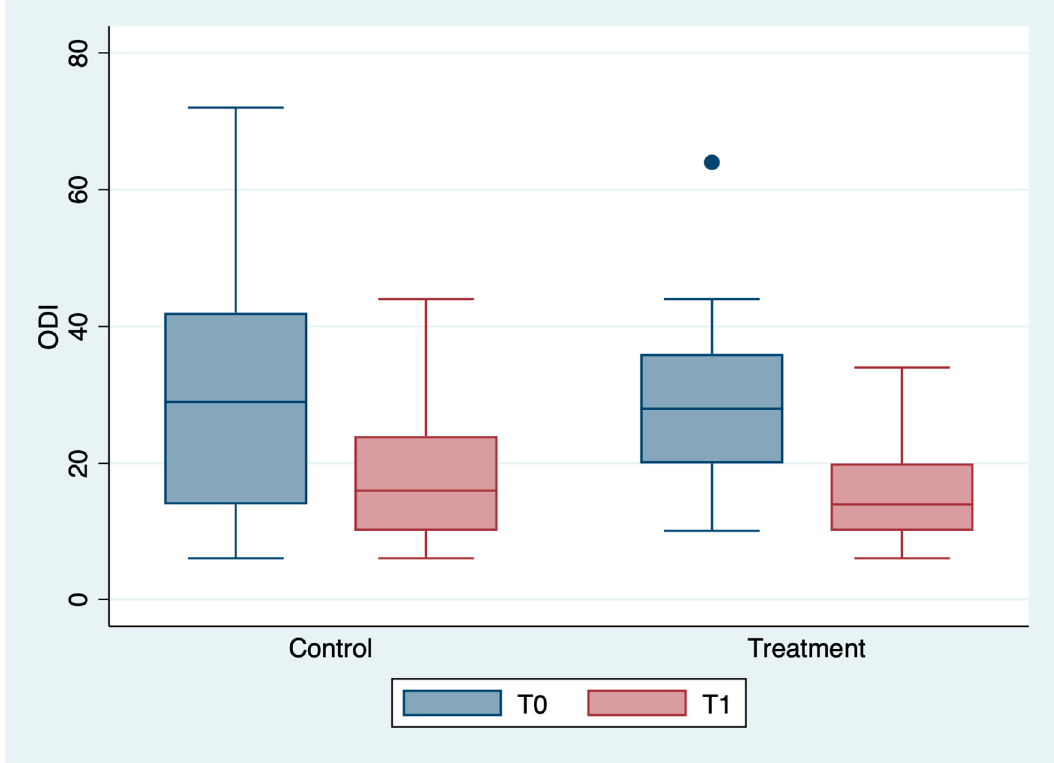
Figure 2. Box plot of ODI values by detection time and group.